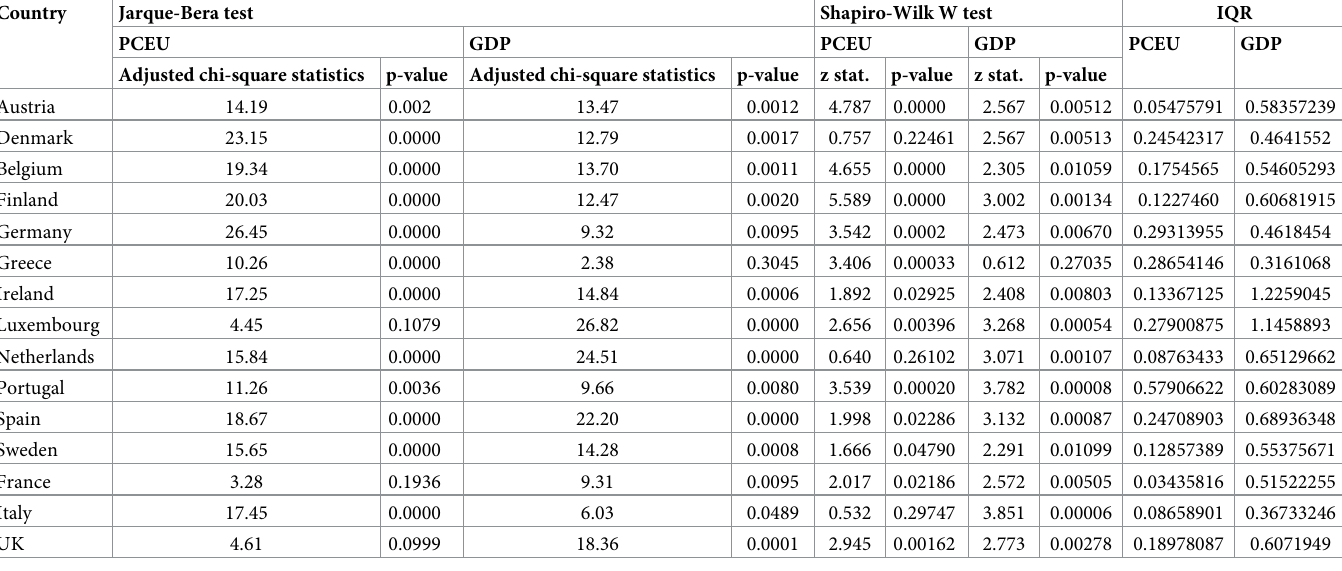
Table 3. Jarque-Bera test, Shapiro-Wilk test and IQR